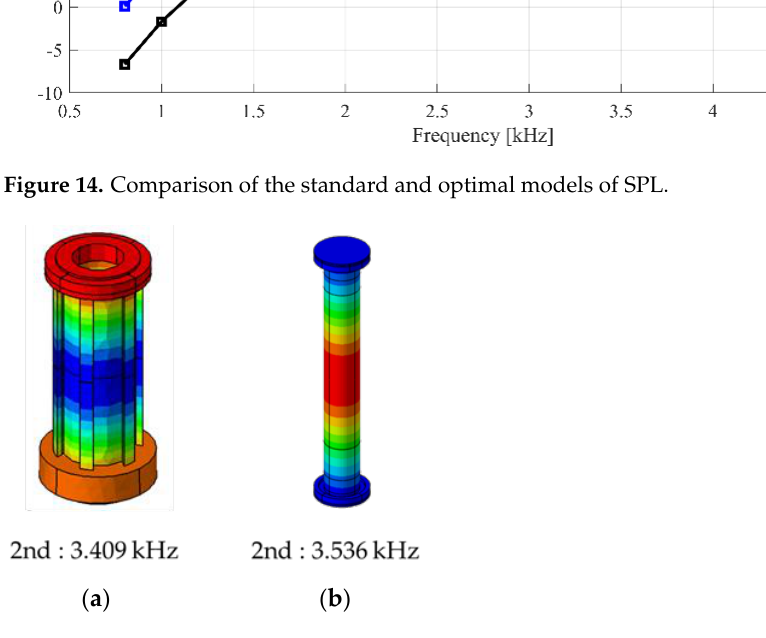
Figure 15. Acoustic mode for the optimal model: ( a ) outside rotor and ( b ) inside